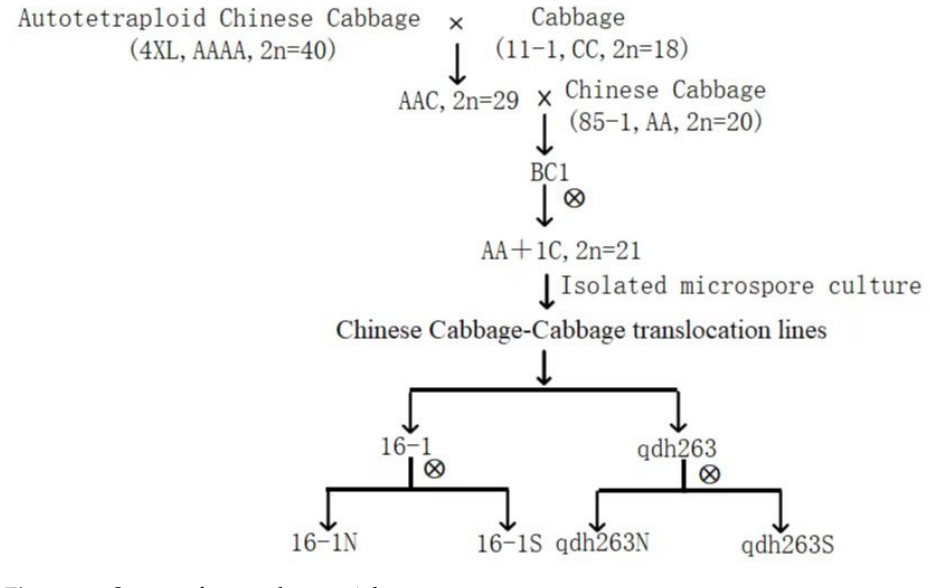
Figure 10. Source of research materials.